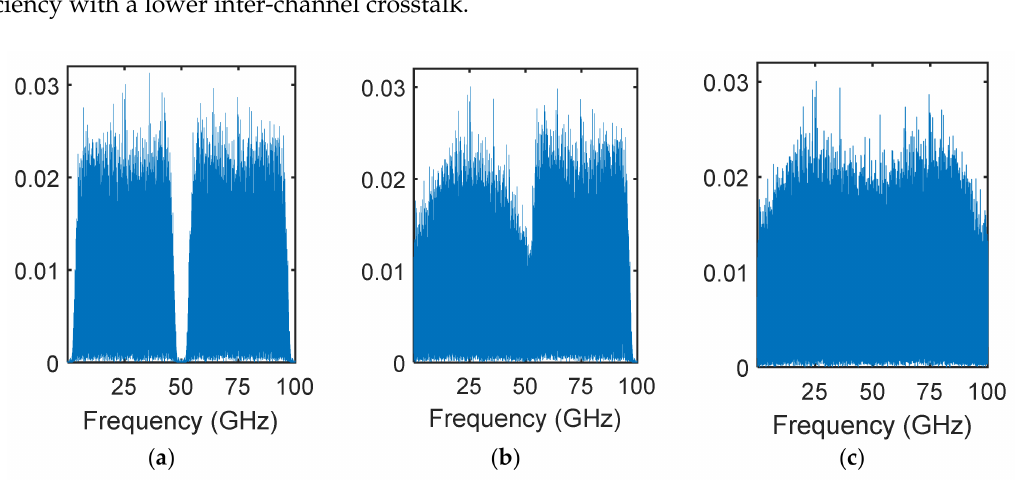
Figure 2. Frequency response with di ff erent roll-o ff factors (ROFs): ( a ) ROF 1 = ROF 2 = 0.1; ( b ) ROF 1 = 1, ROF 2 = 0.1; and ( c ) ROF 1 = ROF 2 =